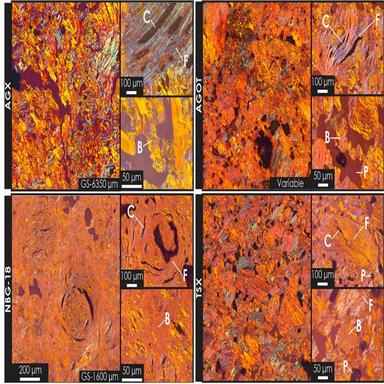
Polarized optical micrographs of historical, coarse and medium-coarse graphite grades. B – Binder, C – Crack, F – Filler, P – Pore. The label GS denotes the grain size of the material; the scale bar in NBG-18 applies to all low magnification micrographs presented.